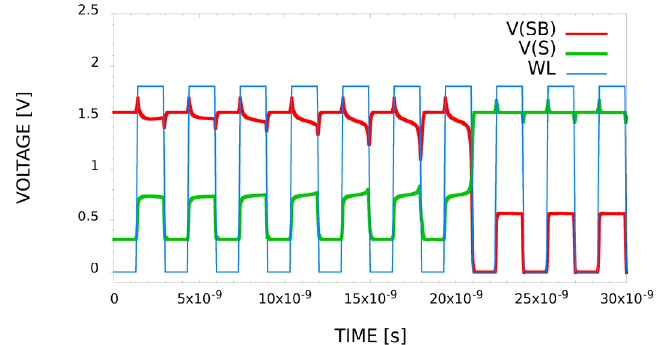
Figure 6. Simulation of a RES test with a bit-flip due to R1 (allowing the fault detection) after several indirect read operations.